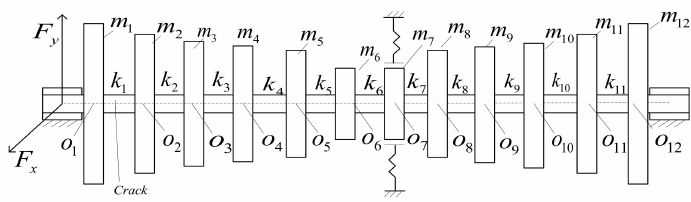
Figure 1. Rotor model with coupling faults (crack and